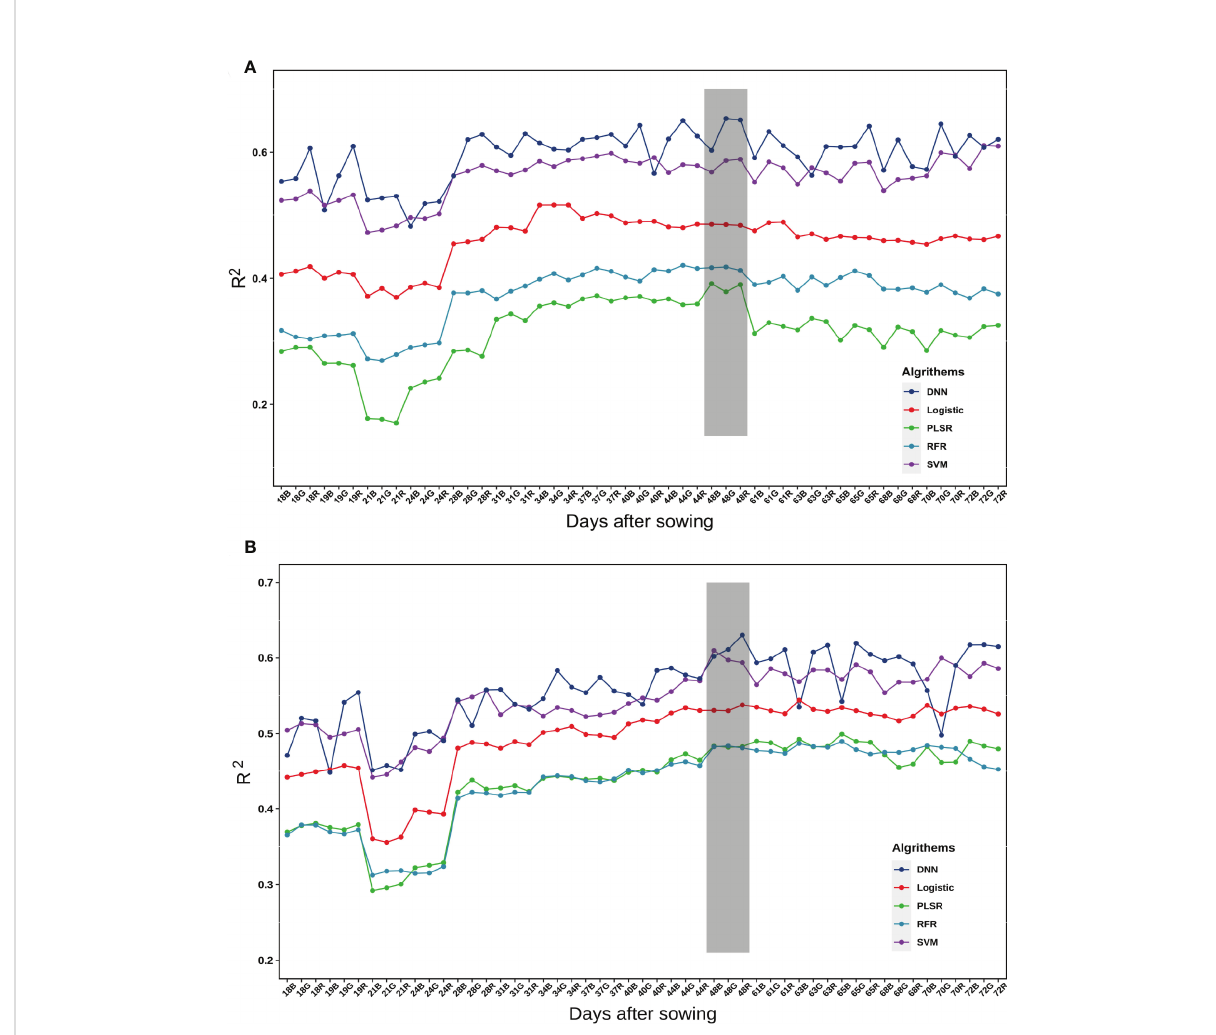
FIGURE 6 Accuracy of the estimation of different models on yield parameters at different dates. (A) Grain number of seeds per plant. (B) Grain weight per plant. The digital numbers represent the days after sowing, and R, G, and B represent the spectral bands. The grey background represents the selected optimal estimation model from day